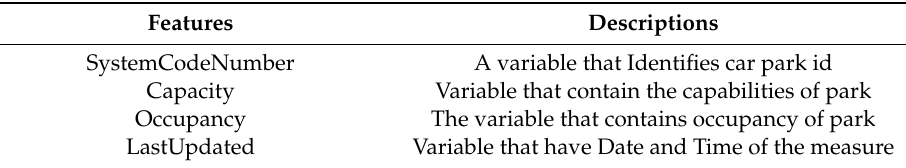
Table 2. Features in Birmingham car park